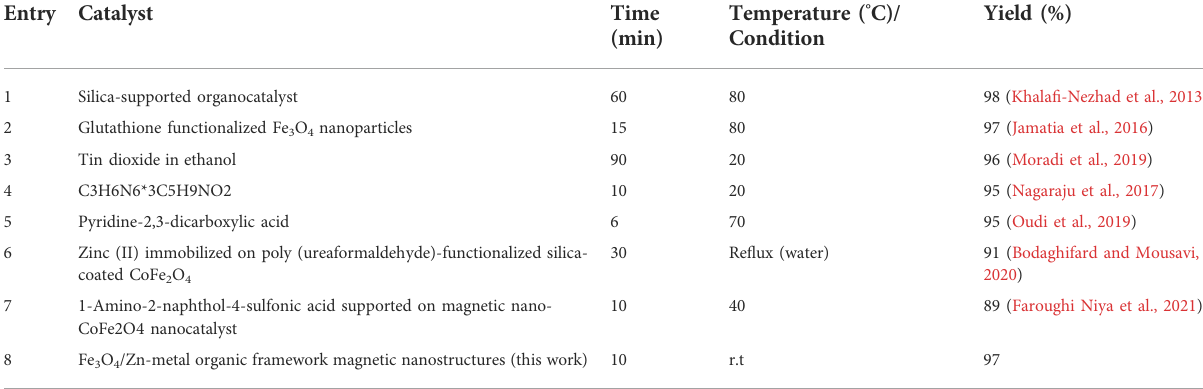
TABLE 4 Reported methods for the synthesis of compound